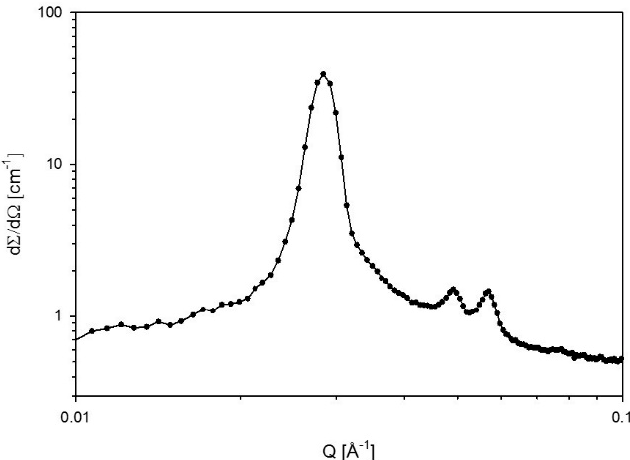
L92/5% MEA. The peak positions follow the ratio 1:2.